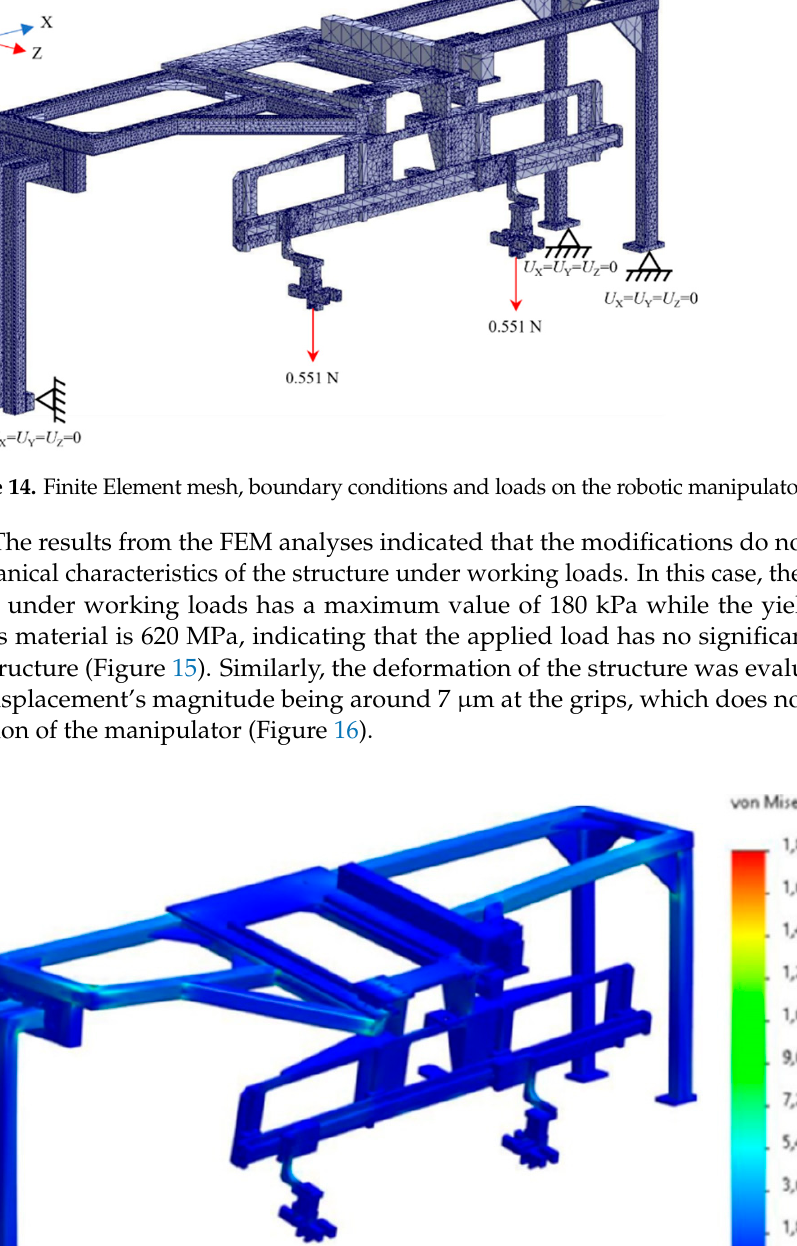
Figure 13. Modified structure for the robotic manipulator: ( a ) standalone structure, ( b ) assembled manipulator.